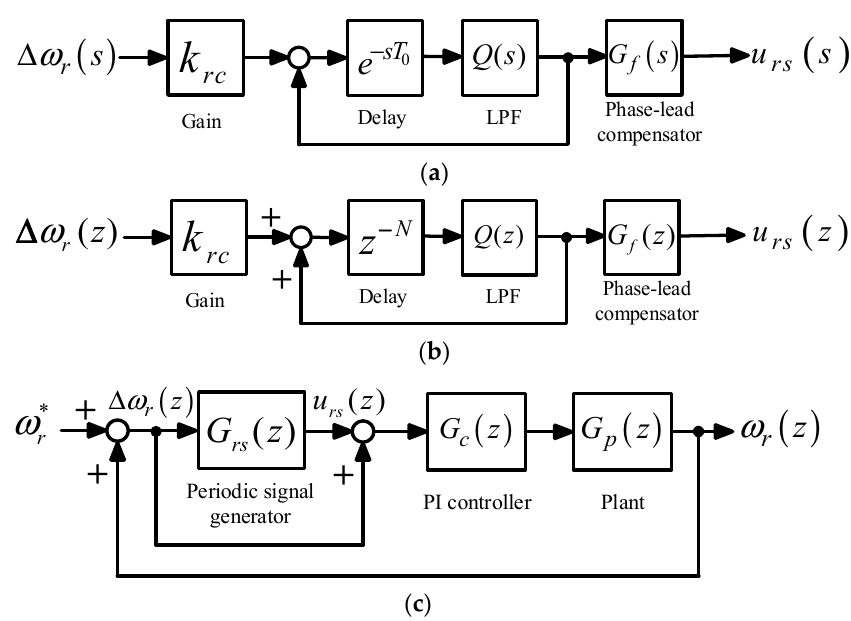
Figure 3. The periodic controller of the speed-loop: ( a ) continuous controller G rs ( s ) ; ( b ) discrete